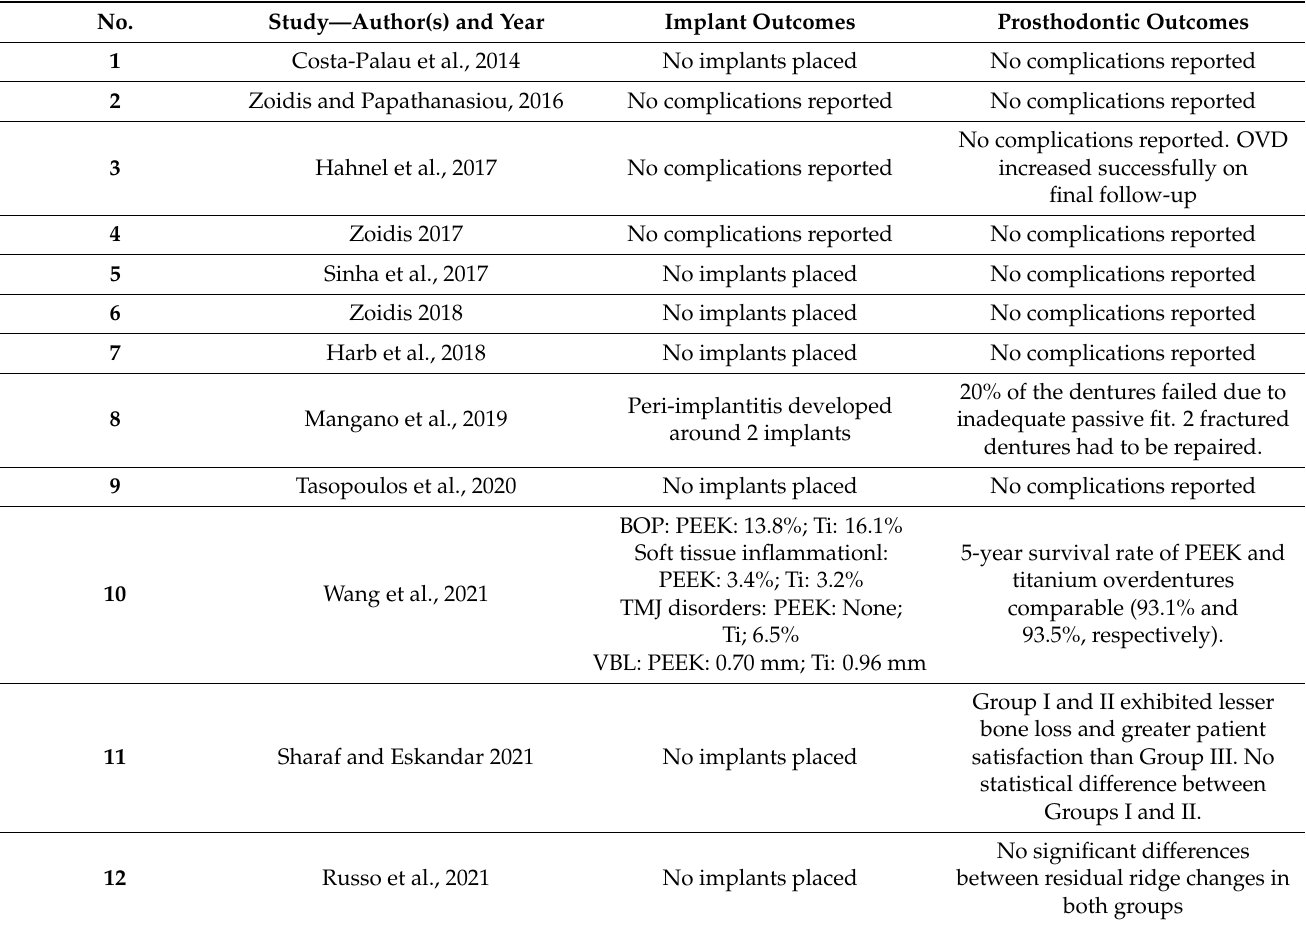
Table 3. Implant and prosthodontic outcomes of studies included in this review. PEEK: polyetheretherketone; BOP: bleeding on probing; TMJ: temporomandibular joint; VBL: vertical bone